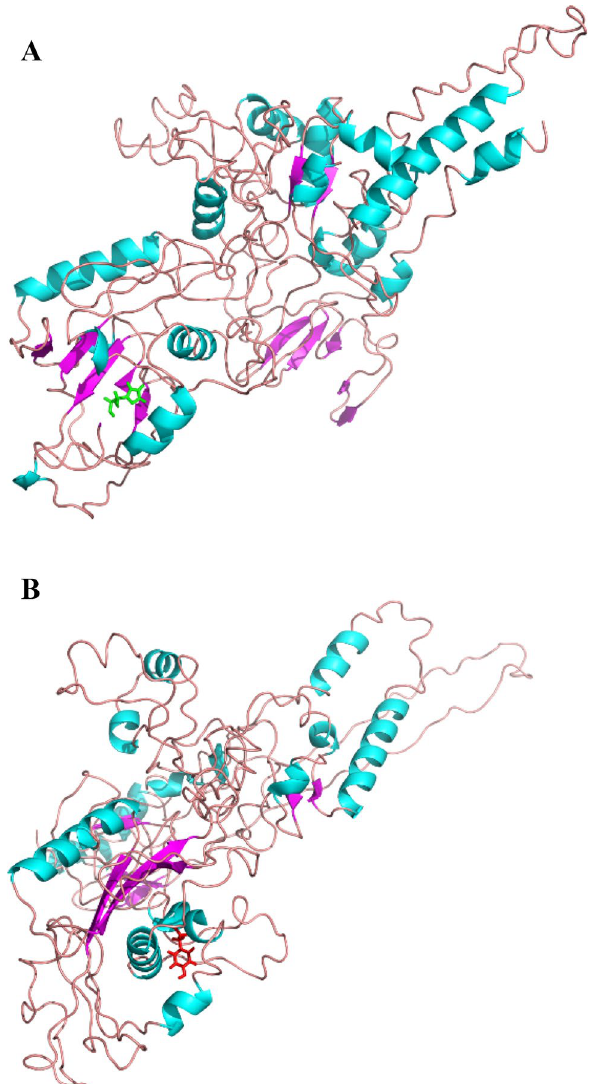
Figure 3. ( A ) In silico modelled structure of the wild-type of GATA6 . The 3D model of the wild-type of GATA6 generated using I-TASSER. The residue His329 is highlighted in stick model (Green colour). The α ‐ helices are represented by cyan ribbons, the β ‐ strands are represented by magentas arrows, and the coiled regions are represented in light pink. ( B ) The residue Tyr329 in the H329Y variant is highlighted in stick model (red colour).